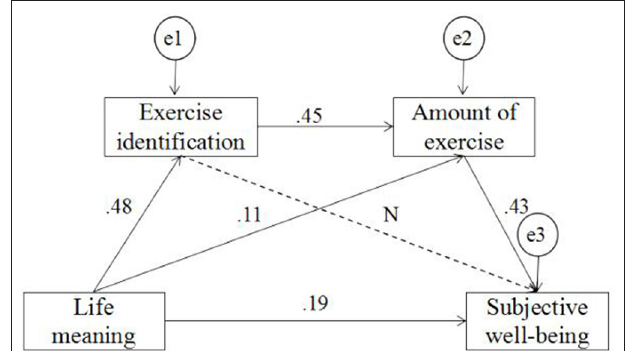
FIGURE 3 | Serial multiple mediation pathways analysis. Solid arrows indicate the significant paths, and dashed arrows indicate not significant path ( N = not significant). “e1, e2, e3” represent the error variables. Unstandardized coefficients are reported on the